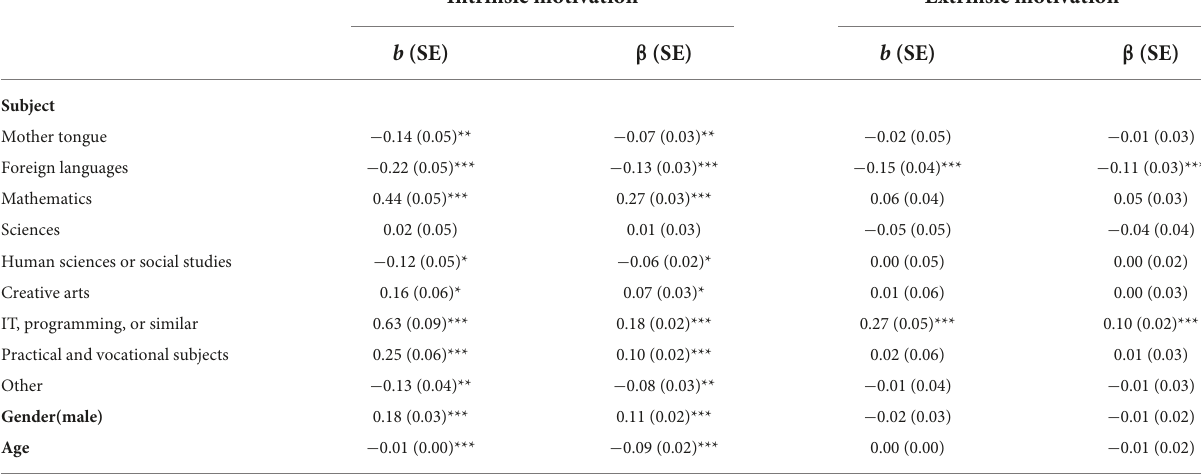
TABLE 7 Estimates (and standard errors) for regression coefficients in teachers’ intrinsic and extrinsic motivation by subjects taught, gender, and